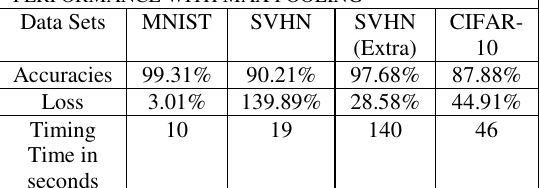
TABLE 4: SUMMARY OF MULTI-BLOCKED MODEL’S PERFORMANCE WITH MAX POOLING Data Sets